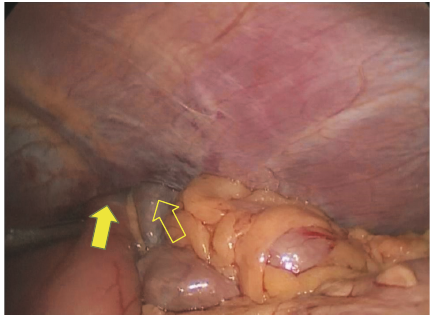
Figure 4: Laparoscopic view showing herniation of the stomach (yellow arrow, filled) and the transverse colon (yellow arrow, not filled) into the thorax.